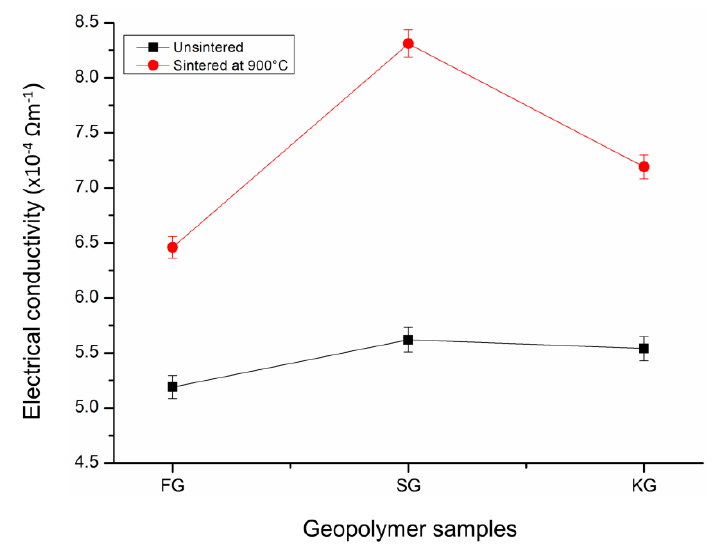
Figure 6. Electrical conductivity of the unsintered and sintered geopolymers at 900 °C.